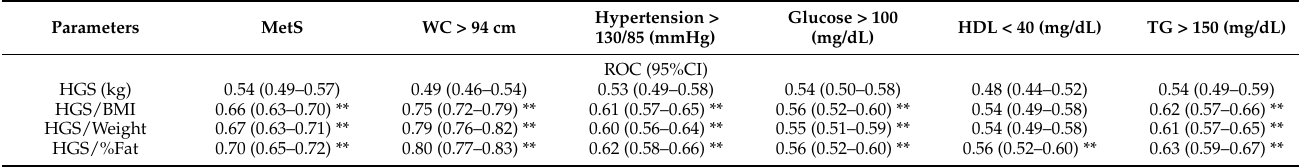
Figure 1. Receiver operating characteristic curve (ROC curve) for handgrip strength (HGS), hand- grip strength adjusted to body mass index (HGS/BMI), handgrip strength adjusted to weight (HGS/weight), and handgrip strength adjusted to body fat percentage (HGS/%Fat) for metabolic syndrome (MetS). Table 2. Receiver operating characteristic curve for handgrip strength, handgrip strength relative to body mass index, handgrip strength relative to weight, and handgrip strength relative to body fat percentage with metabolic syndrome and its components.